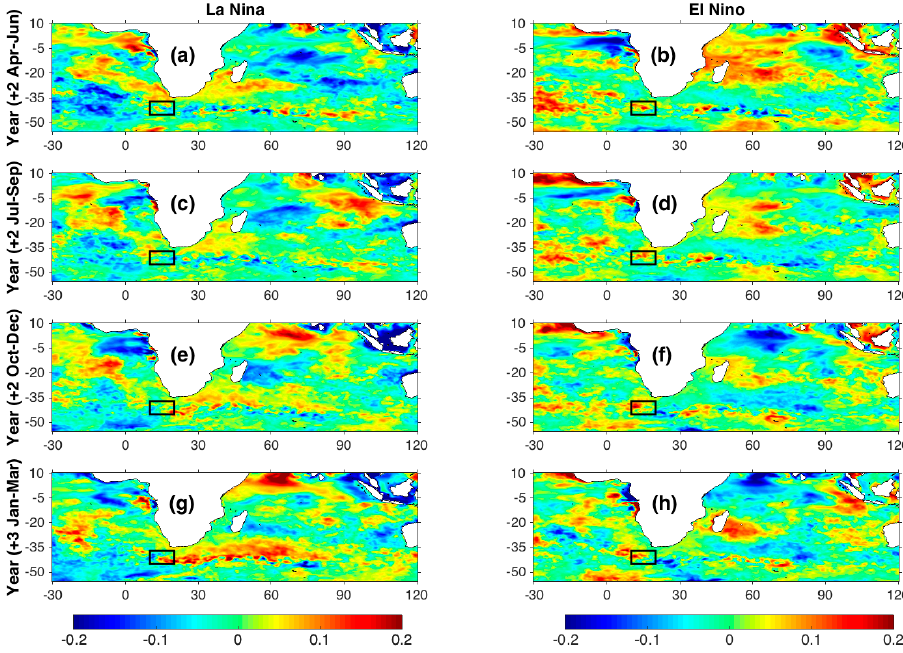
Figure 3. Composite mean of SODA SSS anomalies for all La Niña events (left column) and for all El Niño events (right column) listed in Table 1 two years after the peak for April–June ( a , b ), July–September ( c , d ), October–December ( e , f ), and three years after the peak for January–March ( g , h ). The boxes represent the established leakage region (37°–45°S, 10°–20°E).